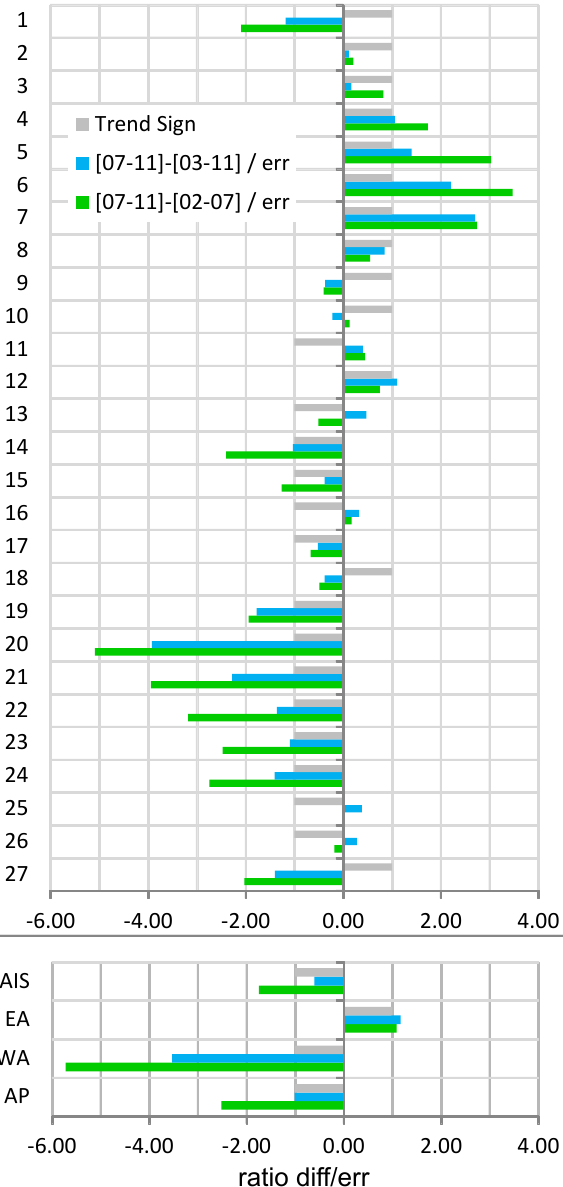
Fig. 10. Acceleration summary for Antarctica.The green bars rep- resents the difference between the trends of two periods with re- spect to the error: trends for August 2007–November 2011 minus trends for August 2002–July 2007. The sky-blue bars represent the difference, with respect to the error, between the trends in the last period and the whole period of GRACE: trends for August 2007– November 2011 minus trends for January 2003–November 2011. The grey bars represents the sign of the trend in the period January 2003–November 2011. The increment (or decrement) ratio is sig- nificant if it has an absolute value greater than one.